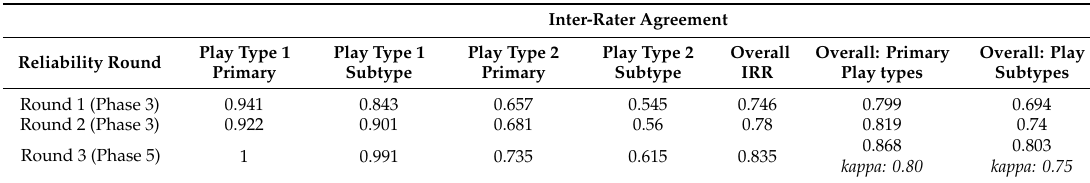
Table 3. Reliability rounds